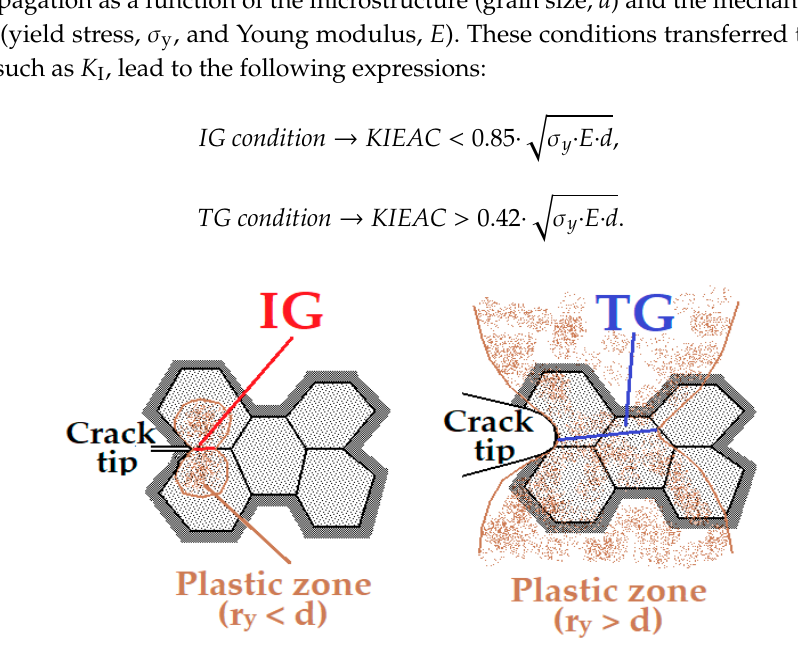
Figure 2. Explanation of intergranular (IG) / transgranular (TG) crack propagation as a function of the grain and the plastic zone sizes.